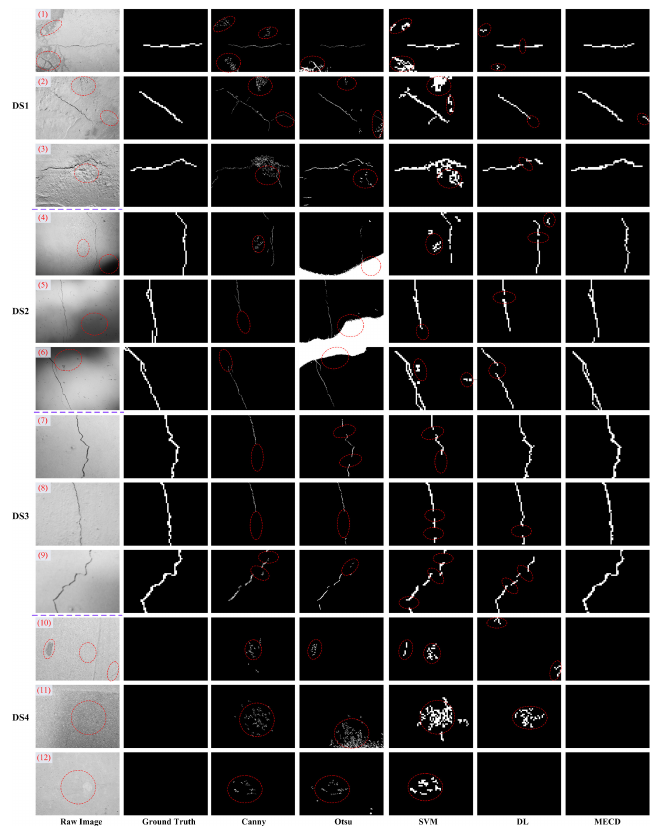
Figure 7. Representative crack damage detecting results under different background disturbances (DS1, Dataset 1), illumination changes (DS2, Dataset 2), image blurring (DS3, Dataset 3), and non-cracks (DS4, Dataset 4). DL, Deep Learning; MECD, Multilayer ELM-based crack detector. (2) Illumination